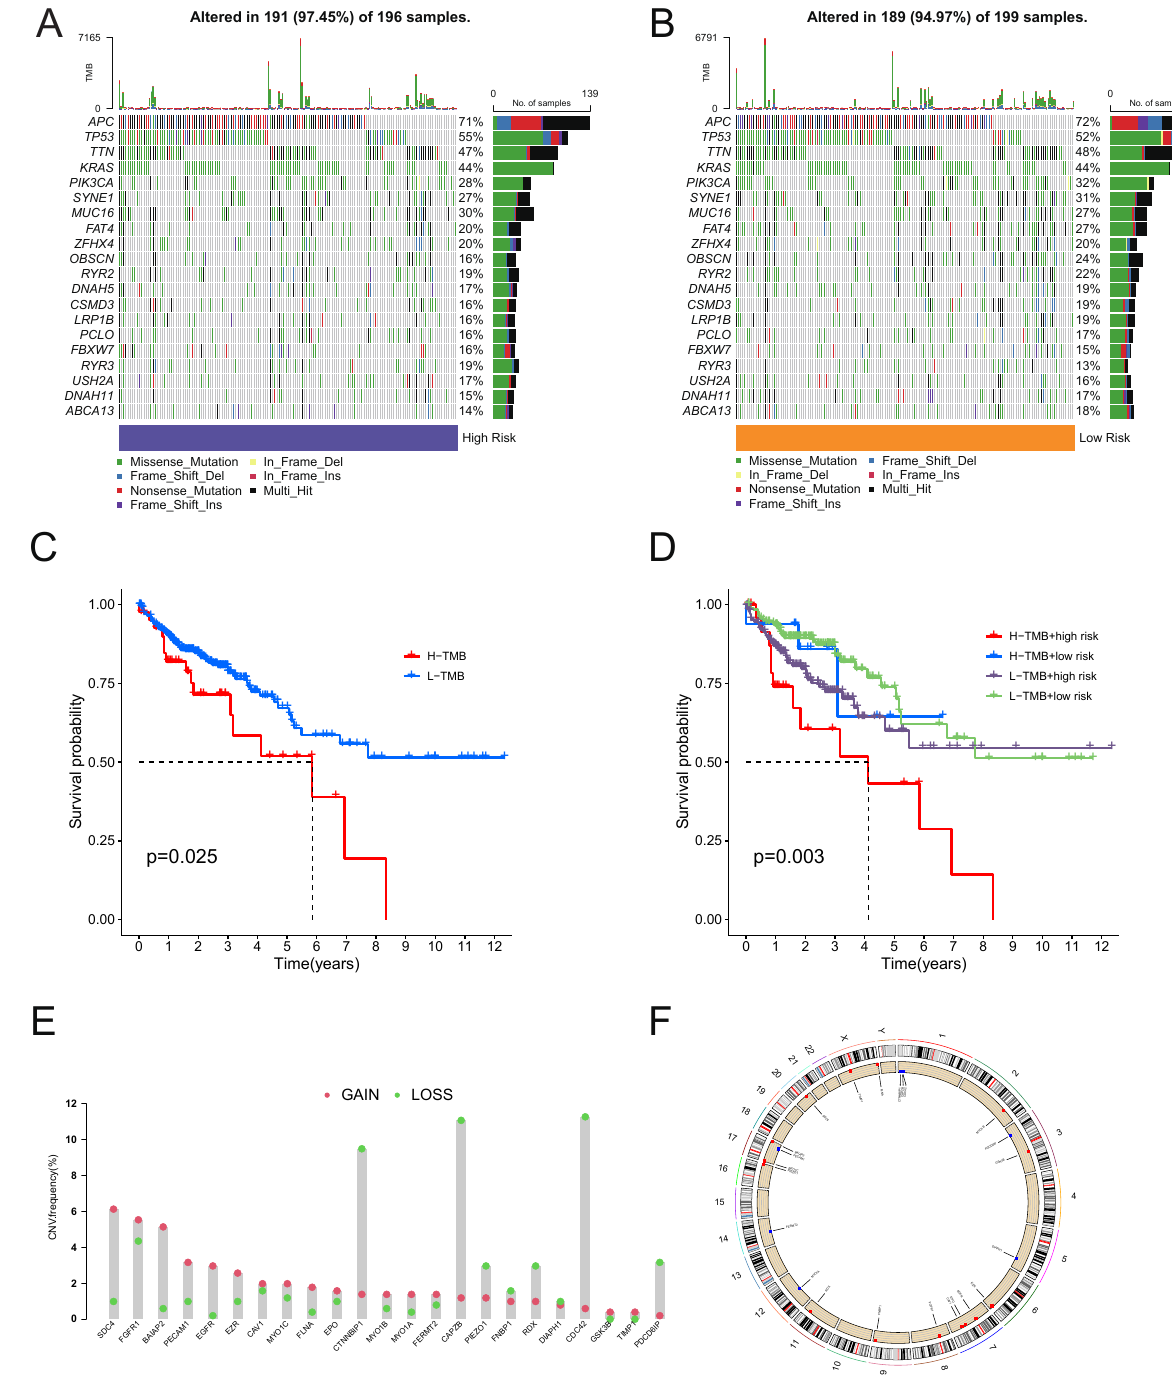
Figure 5. Somatic mutation and CNV analysis in colon cancer patients: ( A , B ) Waterfall plots illustrate the gene mutation landscape in high- and low-risk groups. ( A ) High-risk group; (B ) low-risk group. ( C ) Survival analysis of OS in colon cancer patients between high- and low-TMB groups. ( D ) Survival analysis of OS in colon cancer patients between high- and low-TMB groups based on risk score. ( E ) CNV frequency of 23 MTRGs. ( F ) Genomic position of 23 MTRGs. Bands at the inner circle indicate corresponding expression